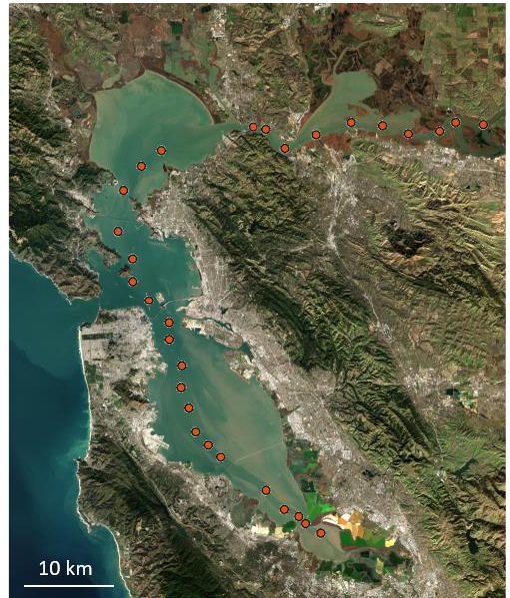
Figure 2 . Sentinel-2 images (2019/12/16) over San Francisco Bay processed by ACOLITE atmospheric correction. In-situ measurement stations are shown in red circles.